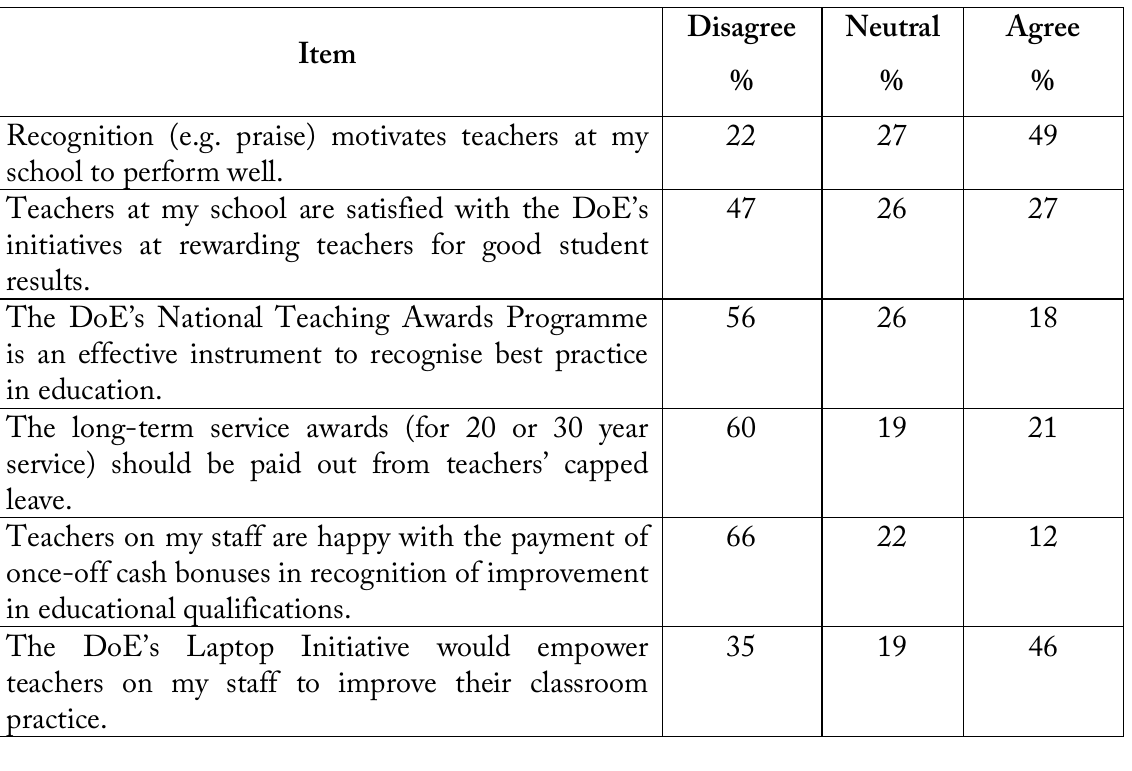
Table 3: Perceptions of performance feedback